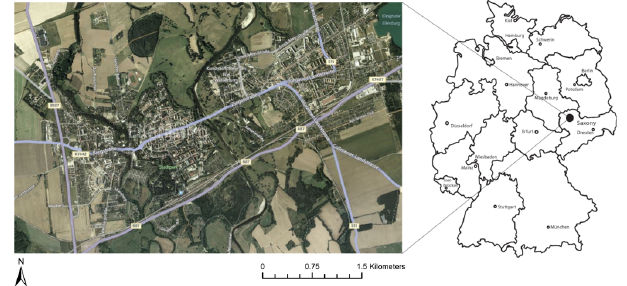
Fig. 1. Location and map of the case study area of Eilenburg in the province of Saxony, Germany.